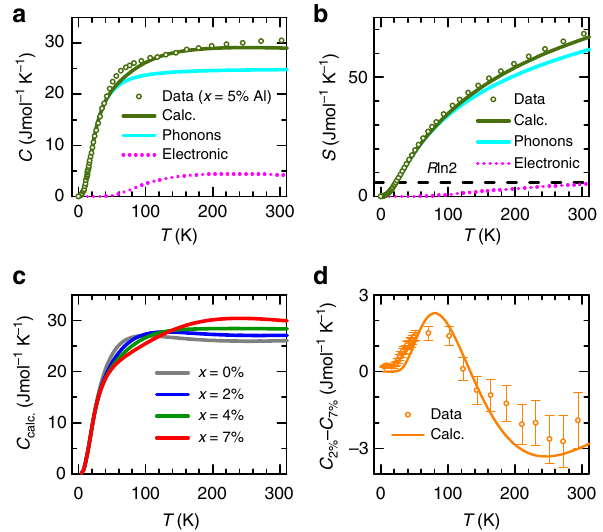
Fig. 4 Heat capacity and Entropy of Ga-stabilized δ -Pu ( δ -Pu 1 − x X x ), where X = Ga or Al. a Calculated heat capacity versus temperature T for x = 5% (solid green line) compared against experimental heat capacity C data (for X = Al and x = 5% (green circles) 17 . The separate calculated phonon (cyan solid line) and electronic (magenta dotted line) contributions are also shown. We neglect possible differences that may exist between X = Al and Ga. b A comparison of the calculated and measured entropy of the same R T ð C = T y Þ d T y . c The calculated heat capacity C composition, where S ¼ calc. 0 for different values of x in different colors, as indicated. d The calculated difference in heat capacity between x = 7% and x = 2% (orange line), compared against the experimentally measured difference (orange circles) together with error bars (corresponding to the standard error of the